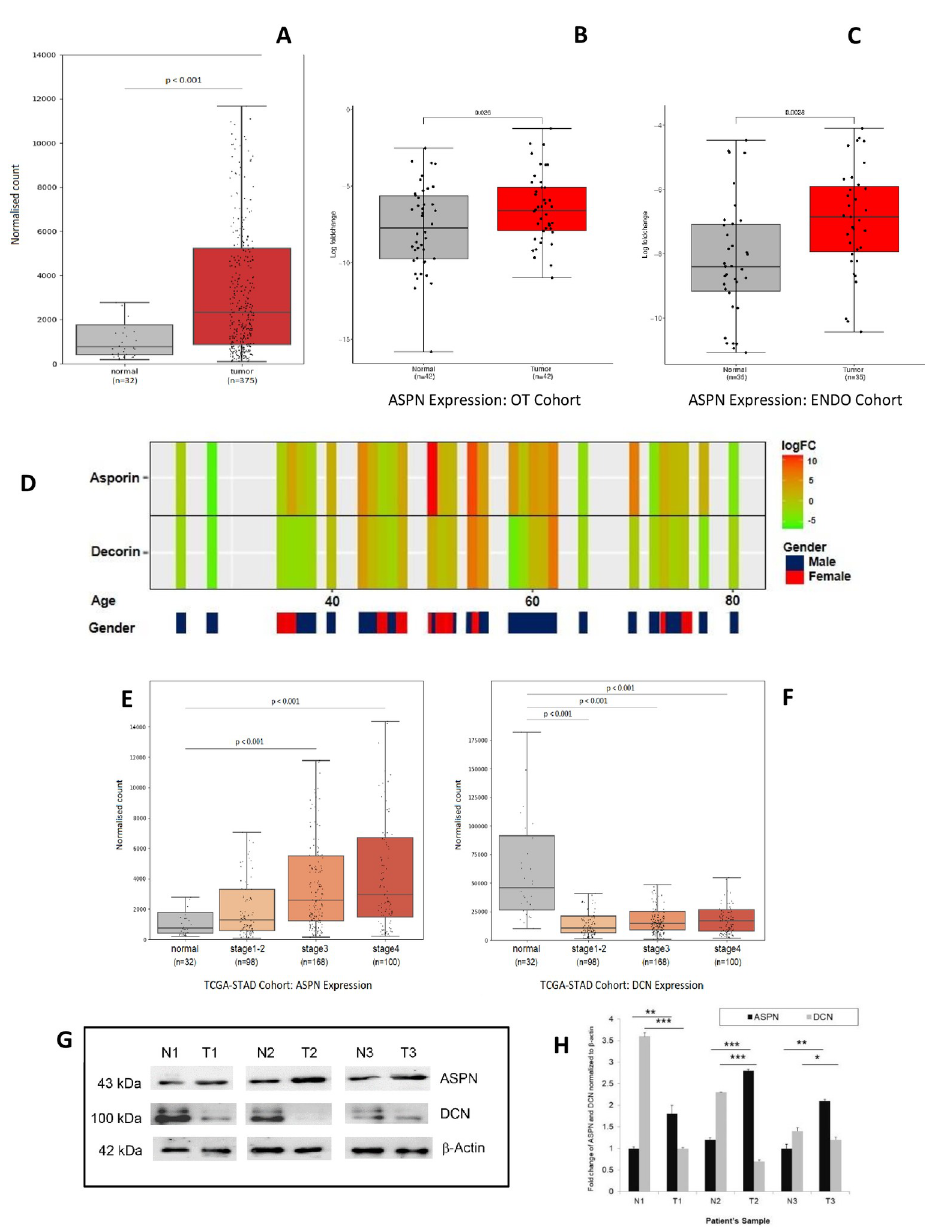
Fig 3. ASPN is upregulated in gastric tumors. (A) ASPN is upregulated in TCGA RNA Seq dataset (n = 407, mean ± SD, ��� p � 0.00,1 likelihood ratio test using DESeq2 method); (B, C) Gene expression analysis using quantitative real-time PCR suggests ASPN is highly expressed in gastric tumor tissue compare to adjacent normal in approx. 61.9% and 61.53% patients in OT Cohort and ENDO Cohort respectively. (n = 42 for OT Cohort and n = 35 for ENDO Cohort, mean ± SD, � p � 0.05, �� p � 0.01, ��� p � 0.001, paired two tailed t test). (D) Heat map of 42 samples based on ASPN and DCN gene expression in our OT cohort. (E, F) ASPN and DCN expression was statistically associated with tumor stage: ASPN is overexpressing with increasing cancer stage whereas DCN showed an opposite result. (n = 398, mean ± SD, � p � 0.05, �� p � 0.01, ��� p � 0.001, likelihood ratio test using DESeq2 method) (G, H) Expression of ASPN and DCN in Gastric tissues, adjacent normal and tumor samples, analysed using western blot assay: T1, T2, T3 are tumor tissues and N1, N2, and N3 are respective corresponding normal tissues.Data were quantified, normalized with β -actin and plotted (n = 3, mean ± SD, � p � 0.05, �� p � 0.01, ��� p � 0.001, student’s t test).